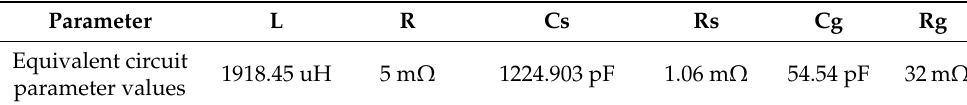
Table 7. Equivalent circuit parameters of healthy windings.